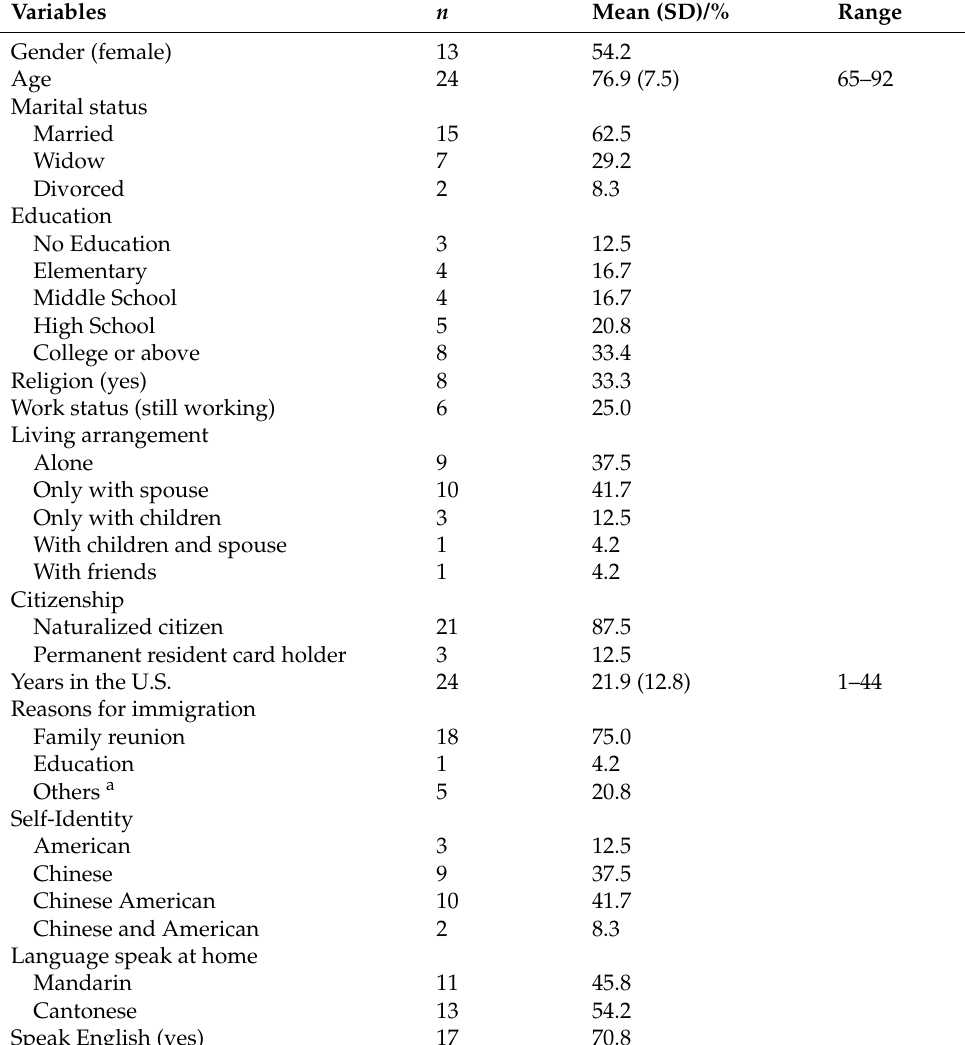
Table 1. Demographic characteristics of participants ( n =